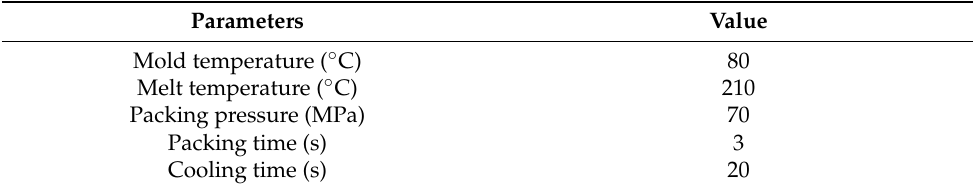
Figure 5. ( a ) Micro ‐ injection molding experiment platform of small ‐ module plastic gears. ( b ) Cavity layout of the mold. ( c ) The actual mold of the studied gear. Table 4. Reference process parameters. Table 4. Reference process